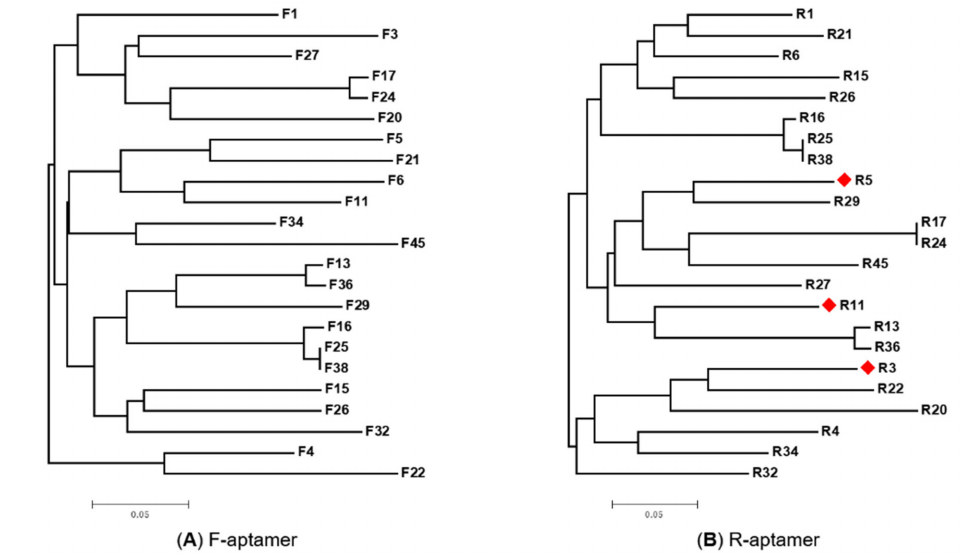
Figure 5. Phylogenetic analyses of 23 selected forward strand aptamers (F-aptamer) and 23 selected reverse strand aptamers (R-aptamer) against the RBSDV P10 protein. Neighbor-joining phylogenic trees of the similarity among 23 F-aptamers ( A ), and 23 R-aptamers ( B ),